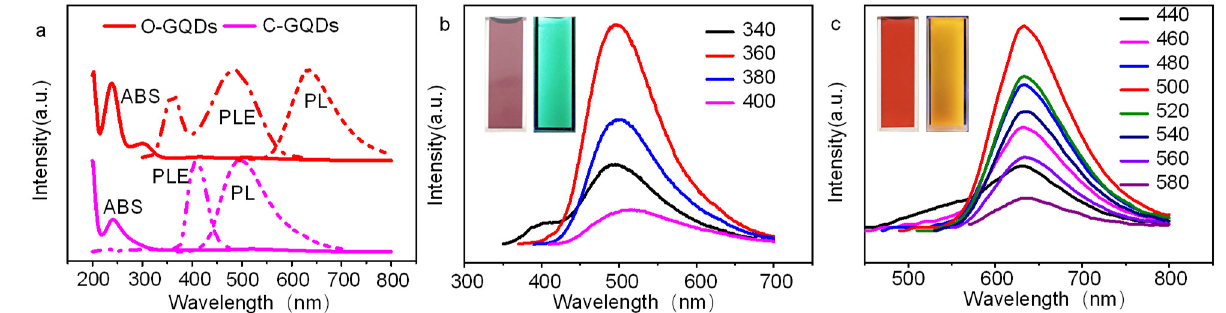
Figure 5. ( a ) UV–Vis absorption spectra and PL spectra of o-GQDs and c-GQDs, ( b ) FL spectra of c-GQDs at different excitation wavelengths, and ( c ) FL spectra of o-GQDs at different excitation wavelengths.